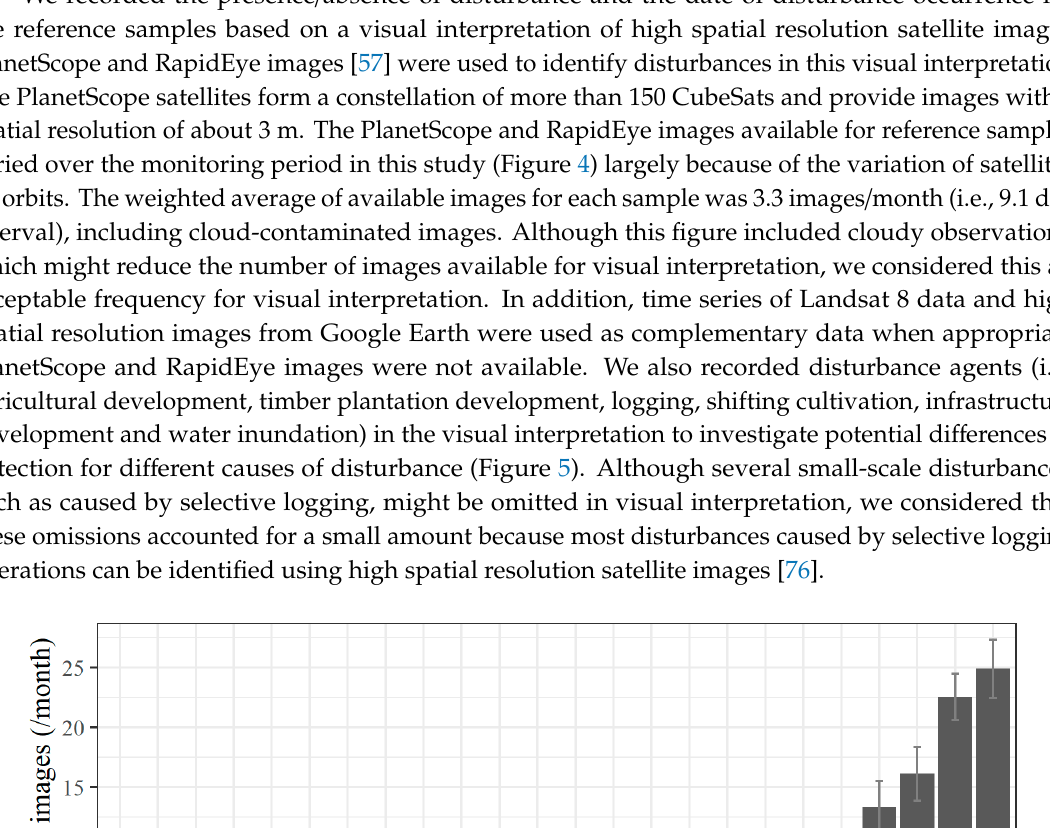
Figure 5. Distribution of samples that experienced disturbance in reference samples. We classified these disturbances for six disturbance agents. 3.5. Validation The performance of the RF models was assessed based on the confusion matrix formed using the 2675 observations from the test samples. We set a disturbance probability of 50% as the threshold for identifying disturbances. The overall accuracy (OA), producer’s accuracy (PA) and user’s accuracy (UA) were calculated using the confusion matrix. In addition, the Brier score [77] was calculated to investigate the prediction performance. This is a measure of probabilistic prediction accuracy expressed as: 𝐵𝑆 = 1 𝑁 (cid:3533)(cid:3435)𝑅 (cid:3036) − 𝑃(cid:4666)𝑑 (cid:3036) (cid:4667)(cid:3439) (cid:2870)(cid:3015) (cid:3036)(cid:2880)(cid:2869)